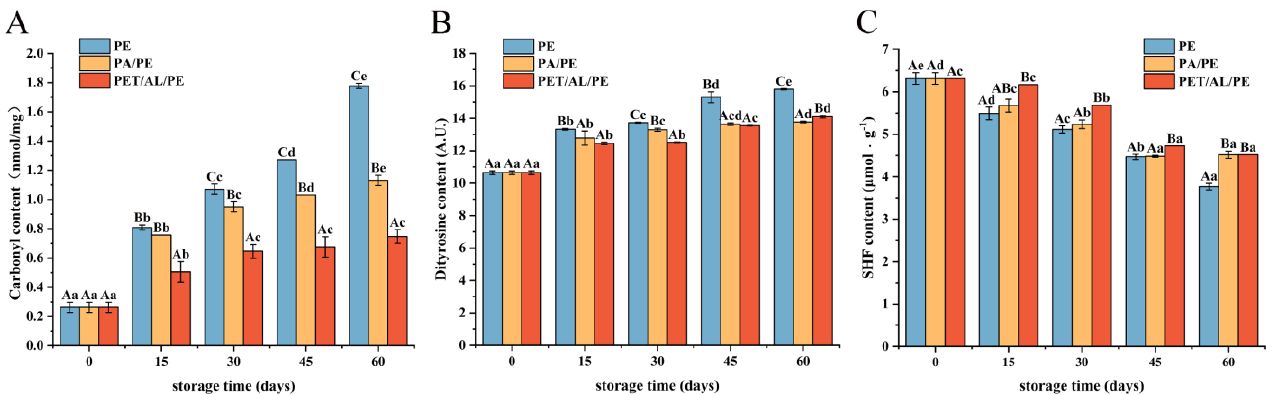
Figure 2. Influence of storage conditions on the content of carbonyl ( A ), dityrosine ( B ), and free sulfhydryl ( C ). In the figures, capital letters represent the differences among package materials in each storage period, lower letters show differences among storage periods in each package at p < 0.05 error level according to Duncan’s multiple range test. The error bar represents the standard error of the mean value.